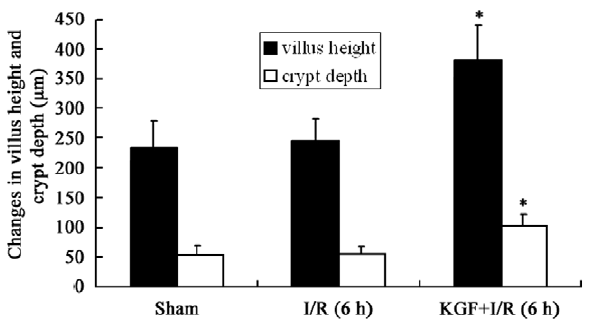
Figure 3. Alterations in villus height and crypt depth in mice after KGF treatment. * P , 0.05 vs. I/R (6 h) group, n=6 per